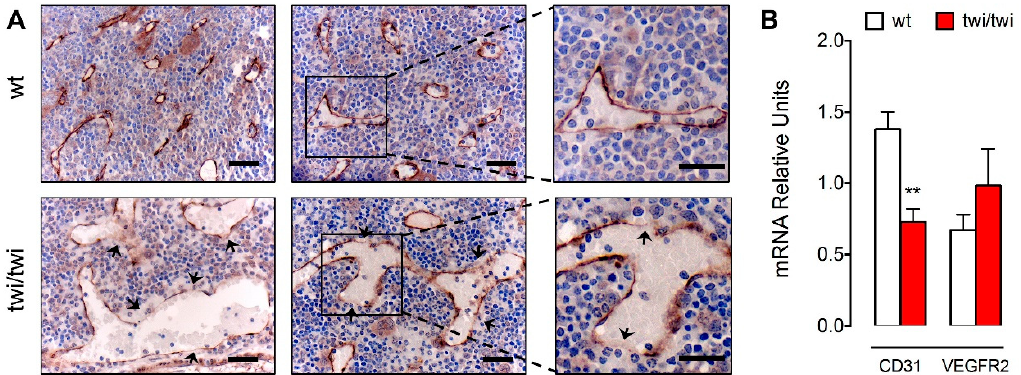
Figure 4. VEGFR2 is expressed by the BM vasculature of twitcher mice. ( A ) VEGFR2 immunohistochemical staining of femoral sections from two wt and two twitcher mice. Arrows indicate endothelial gaps. Scale bar: 50 µ m. Scale bar in magnified fields: 30 µ m. ( B ) Cd31 and Vegfr2 mRNA expression levels in wt and twitcher BM as assessed by RT-qPCR analysis. Data are mean ± SEM of 7–8 animals per group. **, p < 0.01.